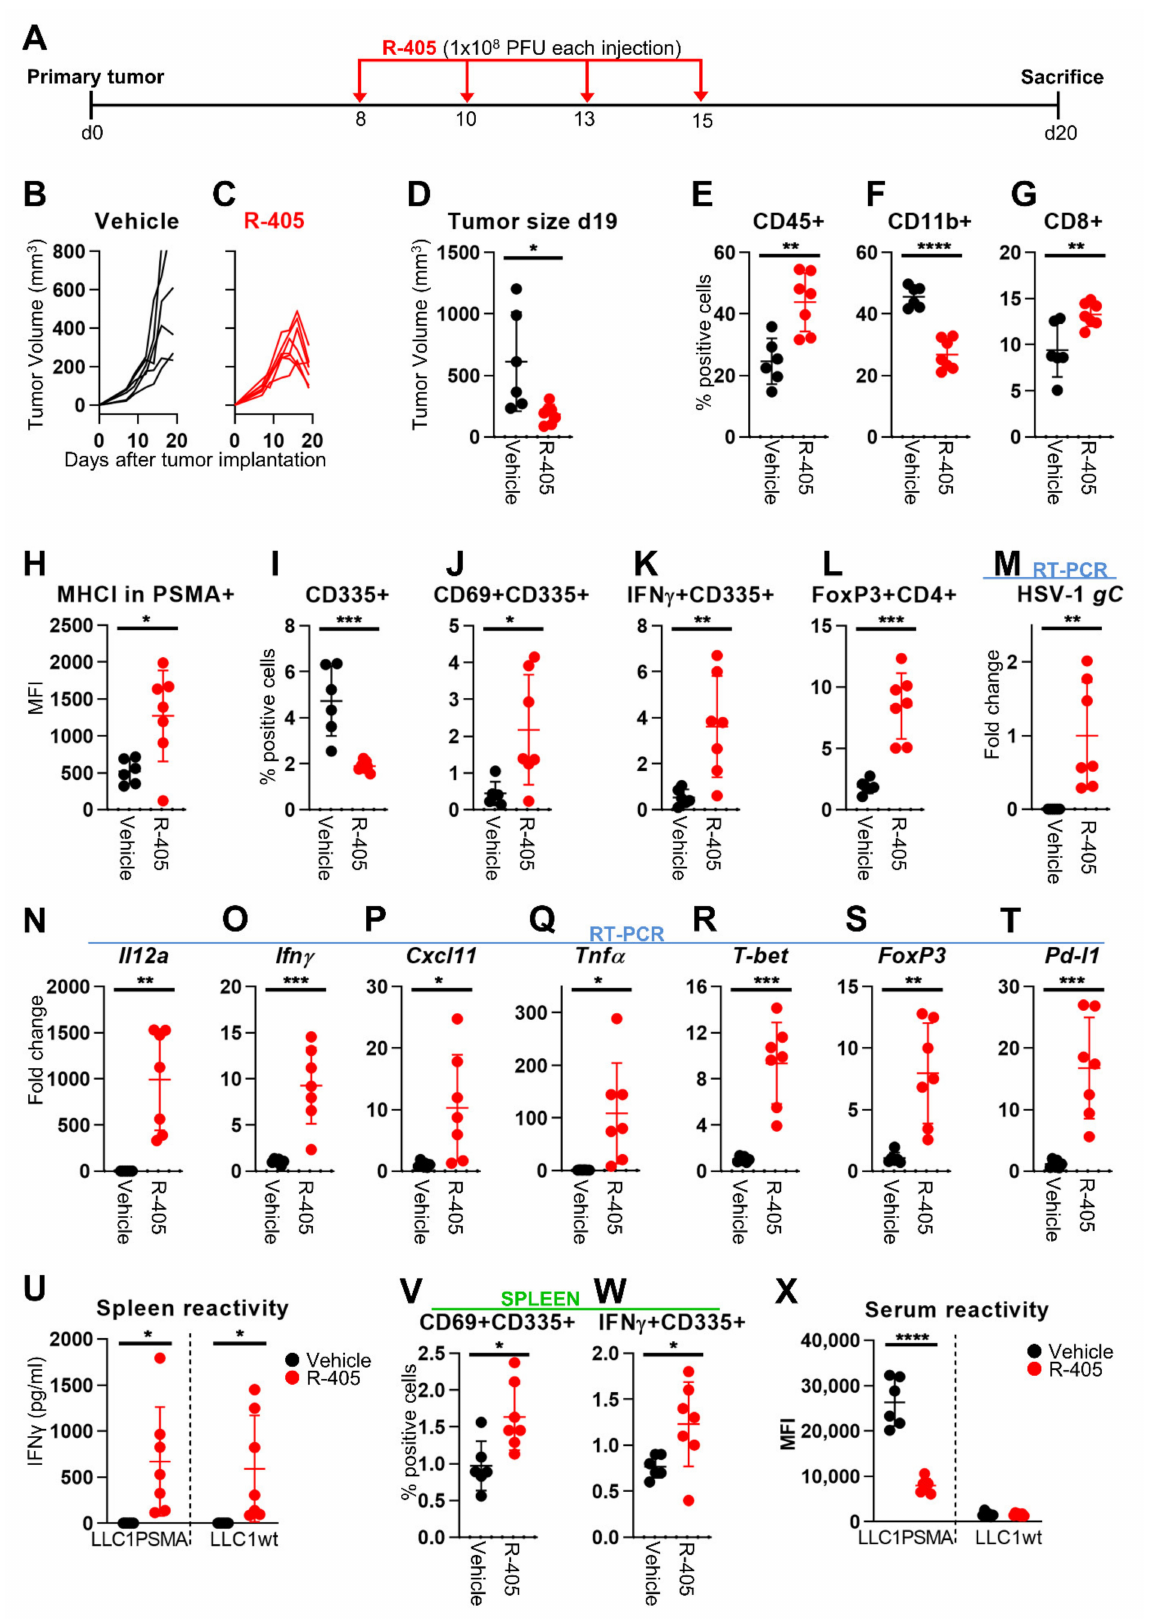
Figure 4. Immune modifications to TME and long-term T and B responses induced by intratumoral R-405 monotherapy. ( A ). Schedule of treatment. ( B , C ) Kinetics of tumor growth in C57BL/6 mice treated with vehicle ( B ) or R-405 ( C ). ( D )